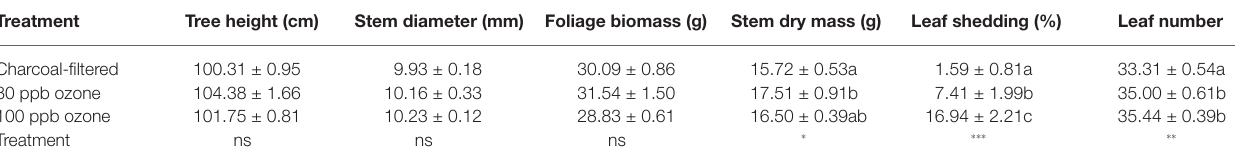
TABLE 1 | Morphological responses to O 3 treatments in hybrid poplar ( Populus tremula x alba ) at the end of the experiment.